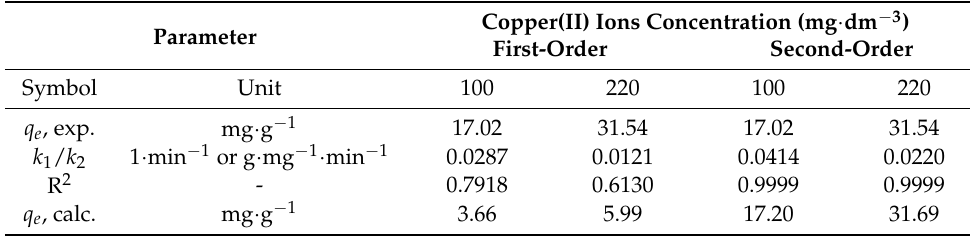
Table 3. Pseudo-first- and second-order kinetic parameters obtained by linear method for adsorption copper(II) on R-SiO 2 -2h hybrid